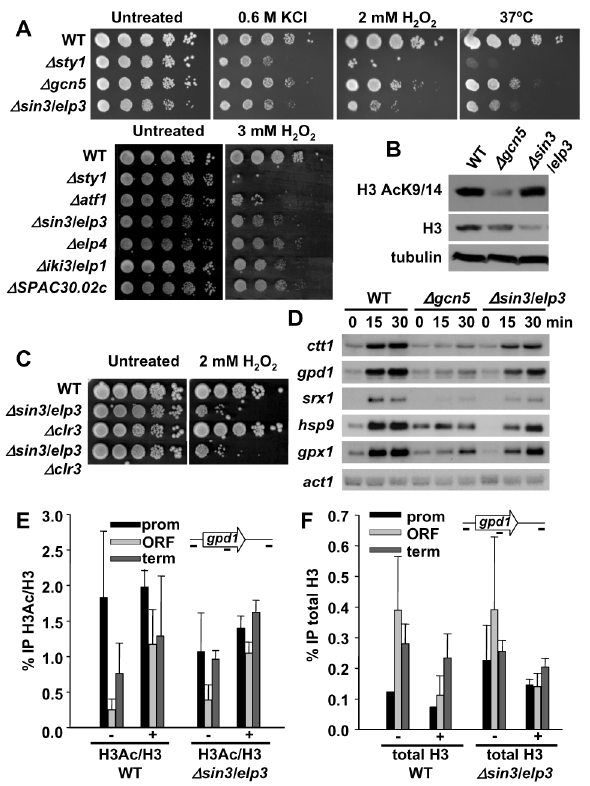
Figure 1. Cells lacking Sin3/Elp3 are sensitive to H 2 O 2 , but do not display major transcriptional defects. (A) D sin3/elp3 strain and other mutants of Elongator complex are sensitive to oxidative stress. Serial dilutions from cultures of strains 972 (WT), AV18 ( D sty1 ), MS161 ( D gcn5 ), IV16 ( D sin3/elp3 ), MS98 ( D atf1 ), IV72 ( D elp4 ), IV66 ( D iki3/elp1 ) and IV68 ( D SPAC30.02c; S. pombe ortholog of kti12 ) were spotted onto rich plates without (Untreated) or with the indicated concentrations of H 2 O 2 or KCl, and grown at 30 u C unless indicated (37 u C). (B) Total levels of histone H3 acetylation at lysines 9 and 14 are not affected in a D sin3/